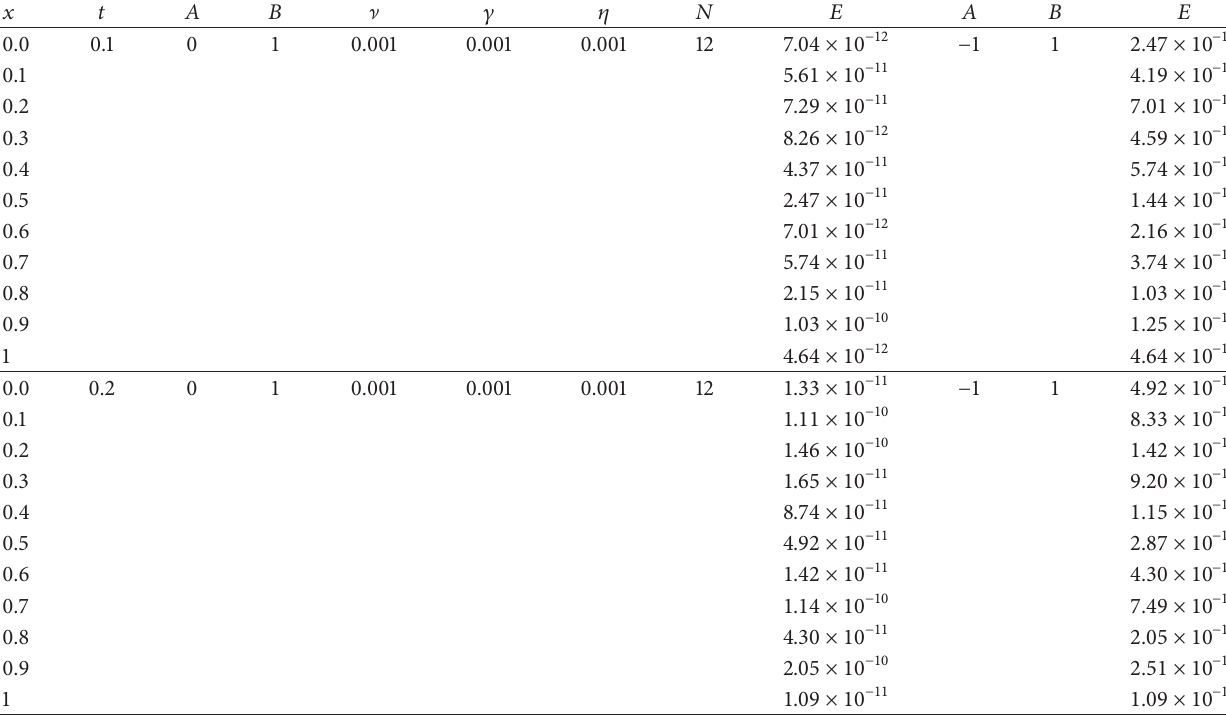
Table 2: Absolute errors with 𝛼 = 𝛽 = 1/2 , 𝛿 = 1 and various choices of 𝑥,𝑡 for Example